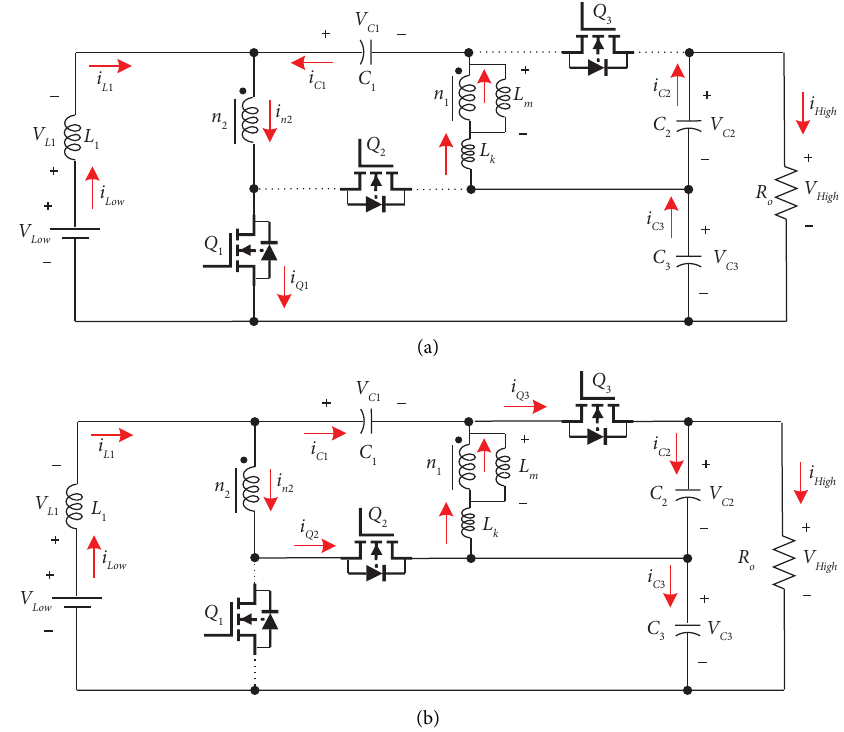
Figure 3: Te equivalent circuits in step-up mode: (a) state 1 and (b) state